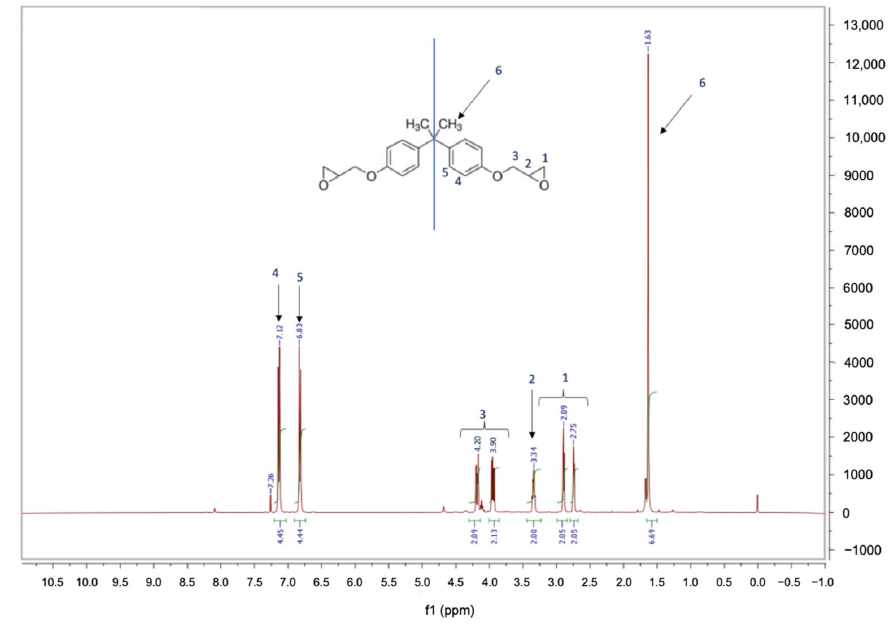
Figure 4. 1 H ‐ NMR spectra of the monomer Recyclamine TM R*101. Figure 4. 1 H-NMR spectra of the monomer Recyclamine TM